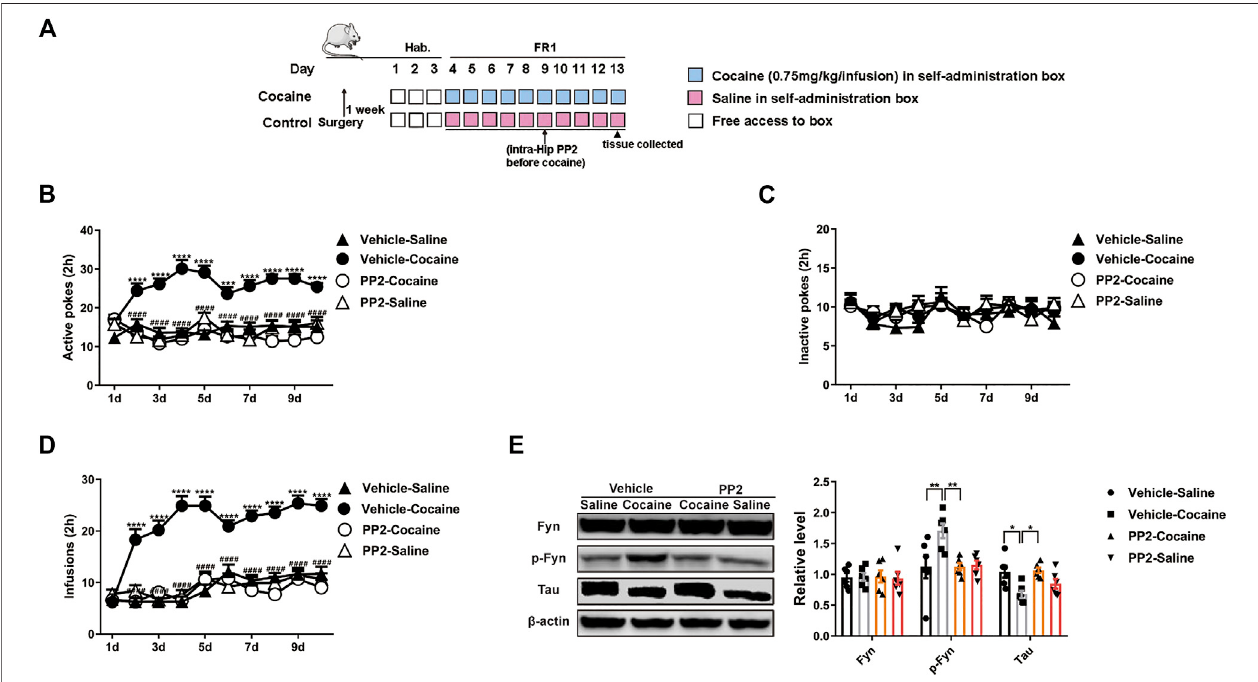
FIGURE 2 | PP2 infusion into the hippocampus disrupts cocaine self-administration. (A) Procedure of cocaine self-administration experiment. (B – D) Number of active pokes, inactive pokes, and infusions in cocaine self-administration ( n = 10 per group). (E) Levels of Fyn, phosphorylated Fyn, and Tau in the hippocampus of cocaine self-administered mice ( n = 6 per group). Data are the means ± SEM, * p < 0.05; ** p < 0.01; *** p < 0.001, and **** p < 0.0001.